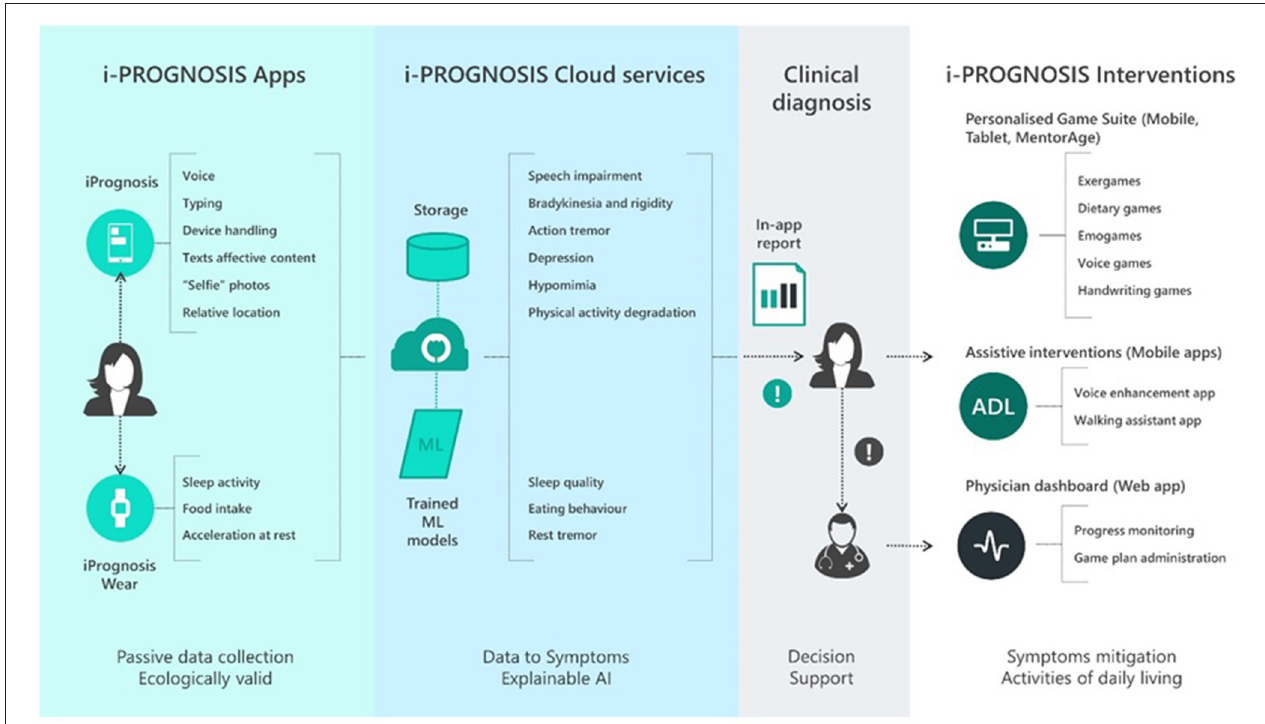
FIGURE 1 | The i-PROGNOSIS ecosystem. AI, Artificial Intelligence; ML, Machine Leaning; ADL, Activities of Daily Living.